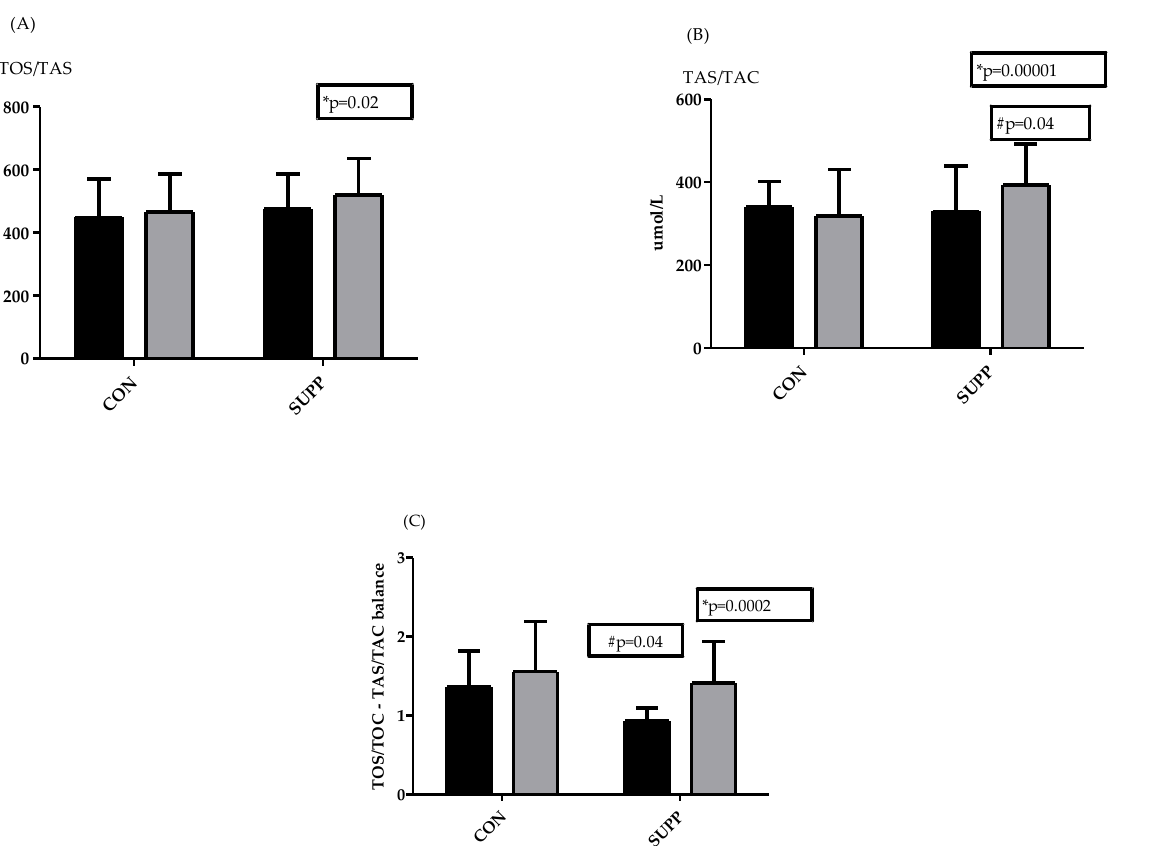
Figure 1. Changes in total oxidative status/capacity (TOS/TOC, ( A )), total antioxidative status/capacity (TAS/TAC, ( B )), and pro/antioxidative balance ( C ), before (dark bars) and after 6 weeks (gray bars) in the CON group and SUPP group. * Significant differences between pre/post values ( p < 0.05); # Significant differences between groups ( p < 0.05). Reference values: EDTA-plasma: <200 mmol/L low oxidative stress; 200–350 mmol/L moderate oxidative stress; >350 mmol/L high oxidative stress; <280 mmol/L low antioxidative status; 280–320 mmol/L moderate antioxidative status; >320 mmol/L high antioxidative status.